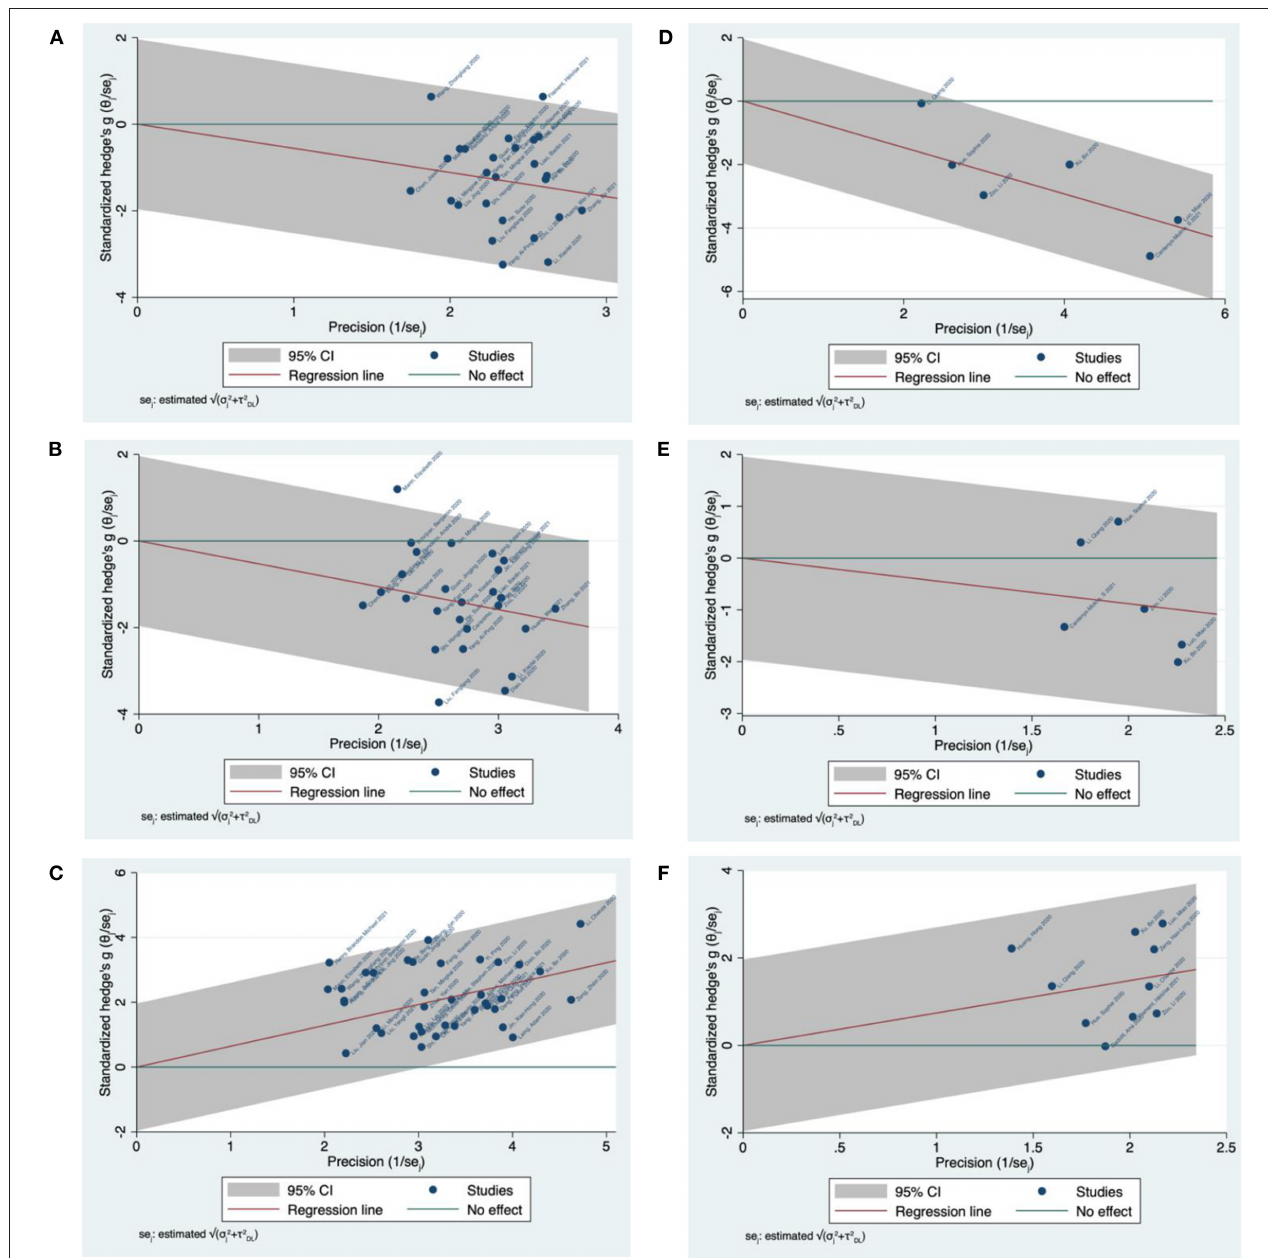
FIGURE 6 | Galbraith plot meta-analysis for CD4/CD8 T-cells and IL-10 in COVID-19 severity and mortality studies. (A) CD4 T-cells in COVID-19 severity studies. (B) CD8 T-cells in COVID-19 severity studies. (C) IL-10 in COVID-19 severity studies. (D) CD4 T-cells in COVID-19 mortality studies. (E) CD8 T-cells in COVID-19 mortality studies. (F) IL-10 in COVID-19 mortality studies.